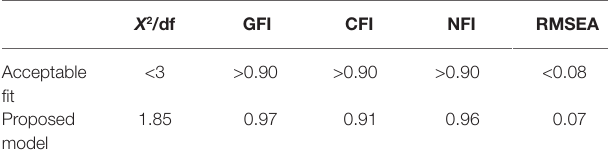
TABLE 3 | The results of Cronbach alpha